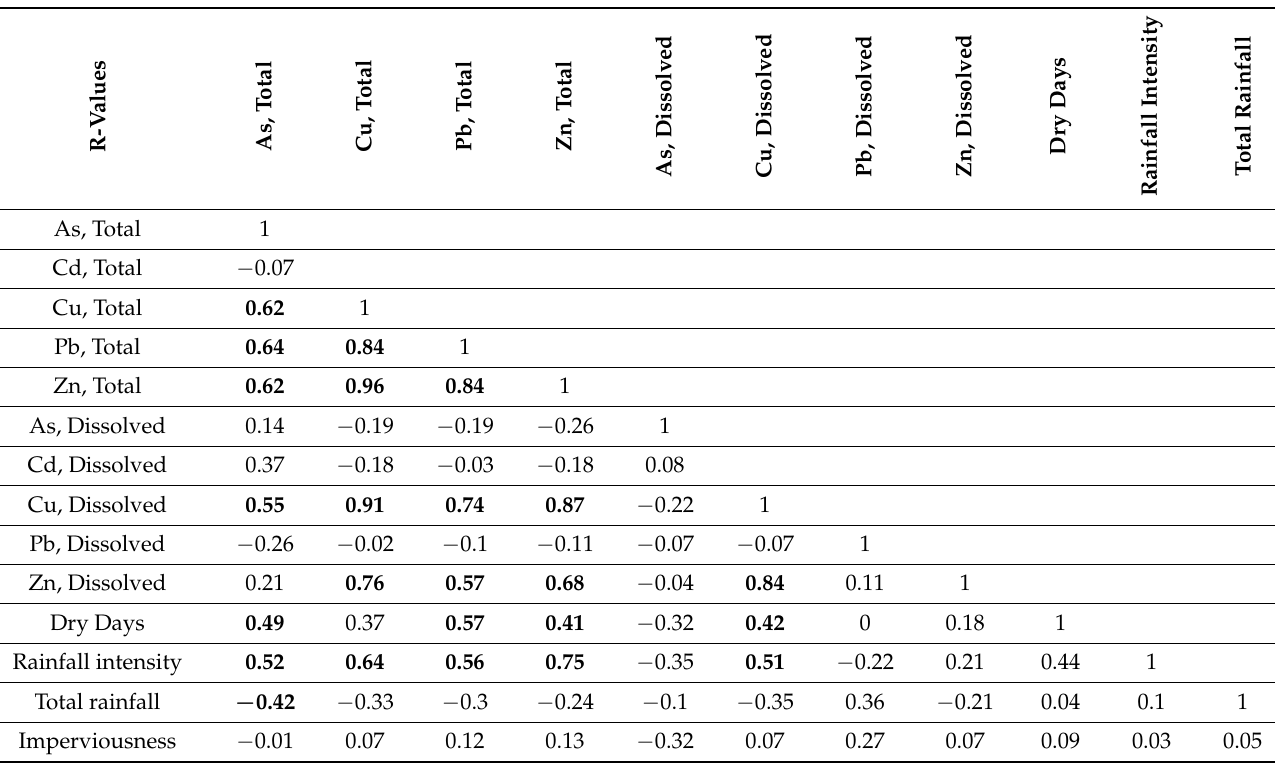
Table A2. Person’s Correlation R-values for wet weather water quality, including metals. Highlighted values are R-values that are statistically significant at the 5% significance level.